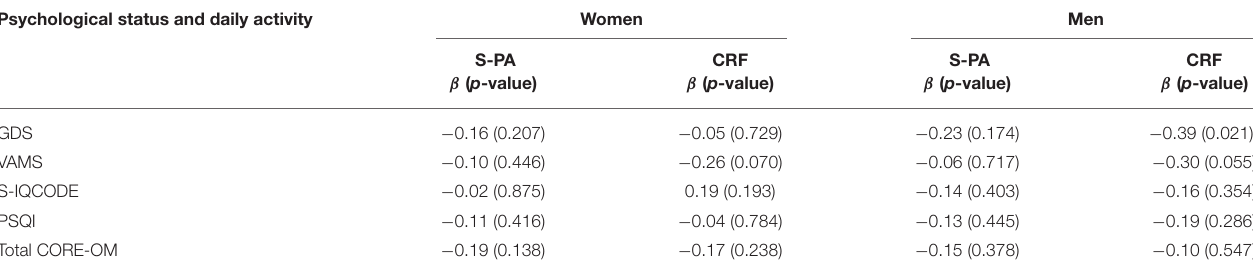
TABLE 4 | Linear regression models in women and men: relationship between physical activity variables and behavior outcomes. Psychological status and daily activity